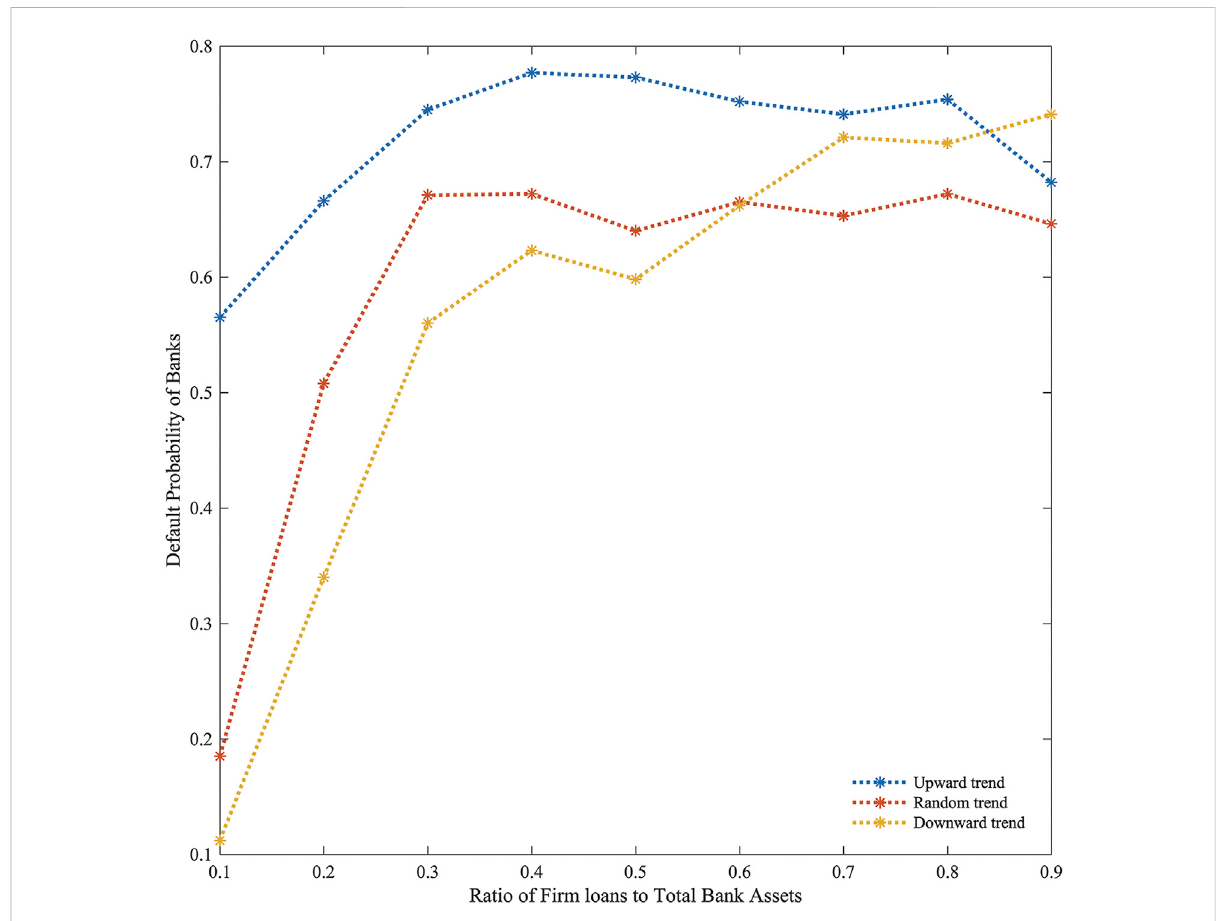
FIGURE 9 The default probability of banks with different ratios of fi rm loans to total bank